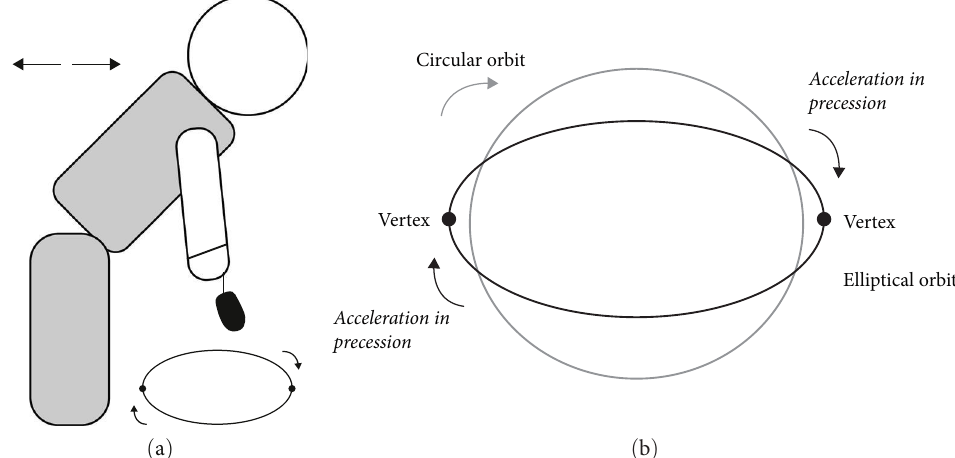
F IGURE 1: (a) Pendulum exercise position, (b) difference between the circular orbit and the pendulum orbit, and the acceleration of the gyroscope (elliptical orbit, representing the arm swing with the working